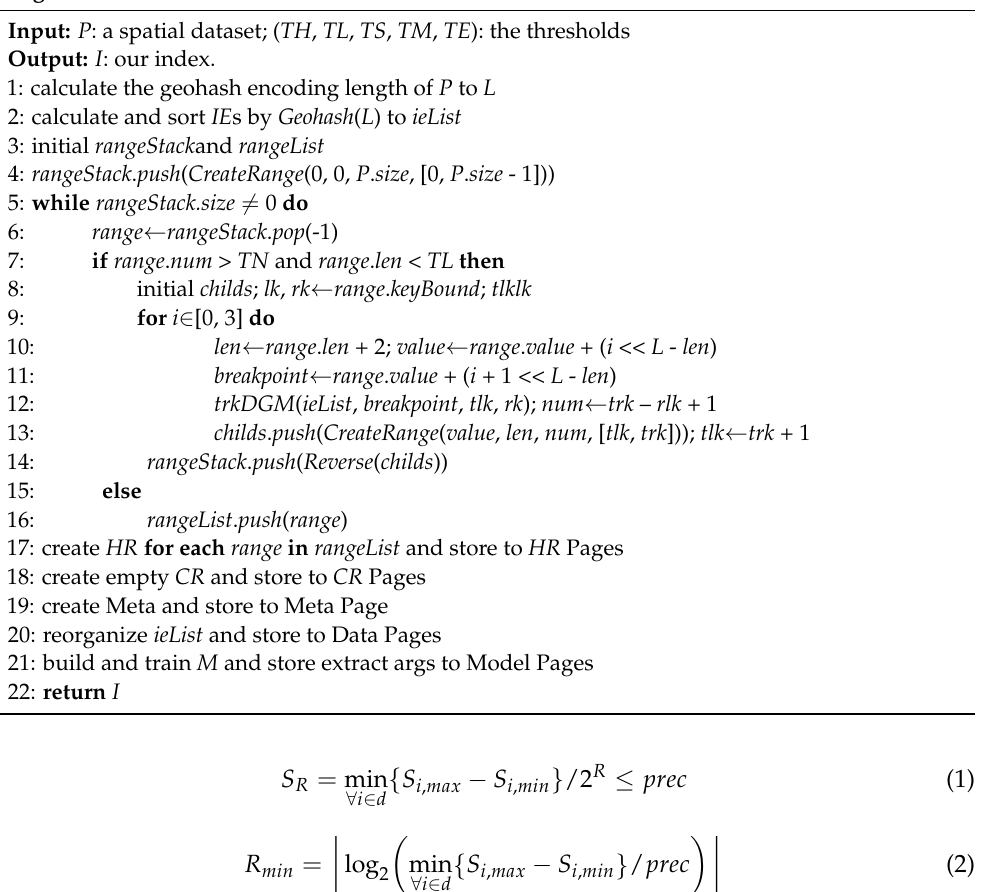
Algorithm 2: Build